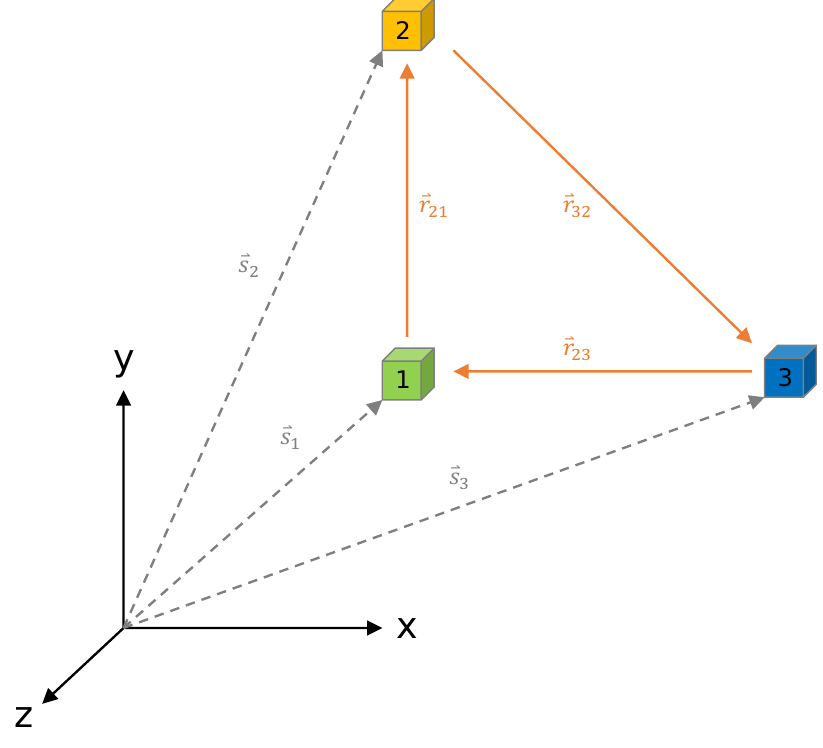
(cid:126) r ji being the reference